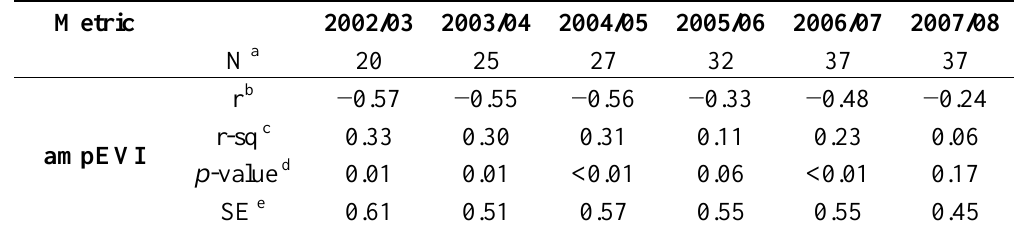
Table 4. Correlation coefficients between variation on EVI metrics and variation on coffee yield the following year for each metric